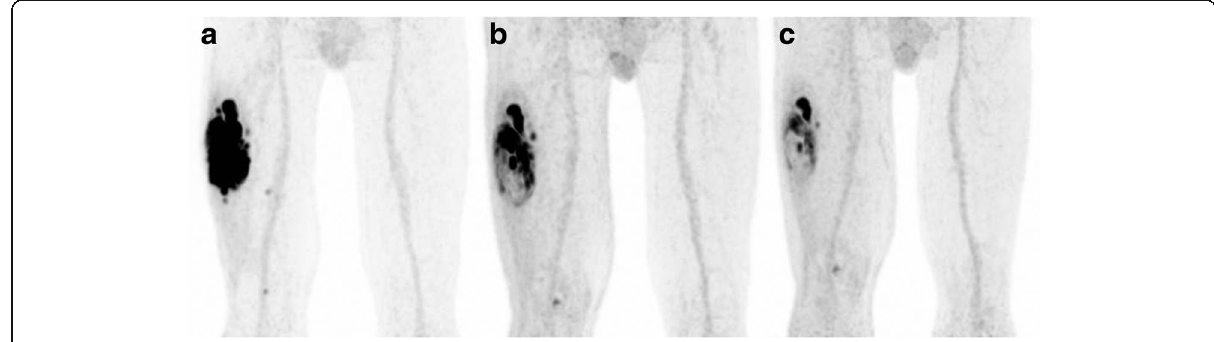
Fig. 1 18 F-FDG uptake throughout the tumor for one of the patients during the treatment course. Coronal 18 F-FDG PET-CT images showing the heterogeneous 18 F-FDG uptake throughout the tumor for one of the patients during the treatment course. a Scan 1 (baseline). b Scan 2 (after HILP). c Scan 3 (after